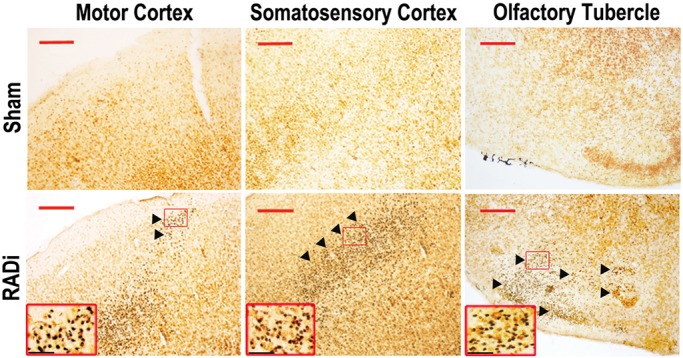
Neuronal degeneration in RADi mouse cortex at 30 dpi following 60 psi×60 RADi. Silver staining showed neuronal degeneration (dark cells, arrowheads) in primary motor cortex, primary somatosensory cortex, and olfactory tubercle. Insets show higher magnifications of the boxed areas. Scale bars: 100 μm (red), 25 μm (black).